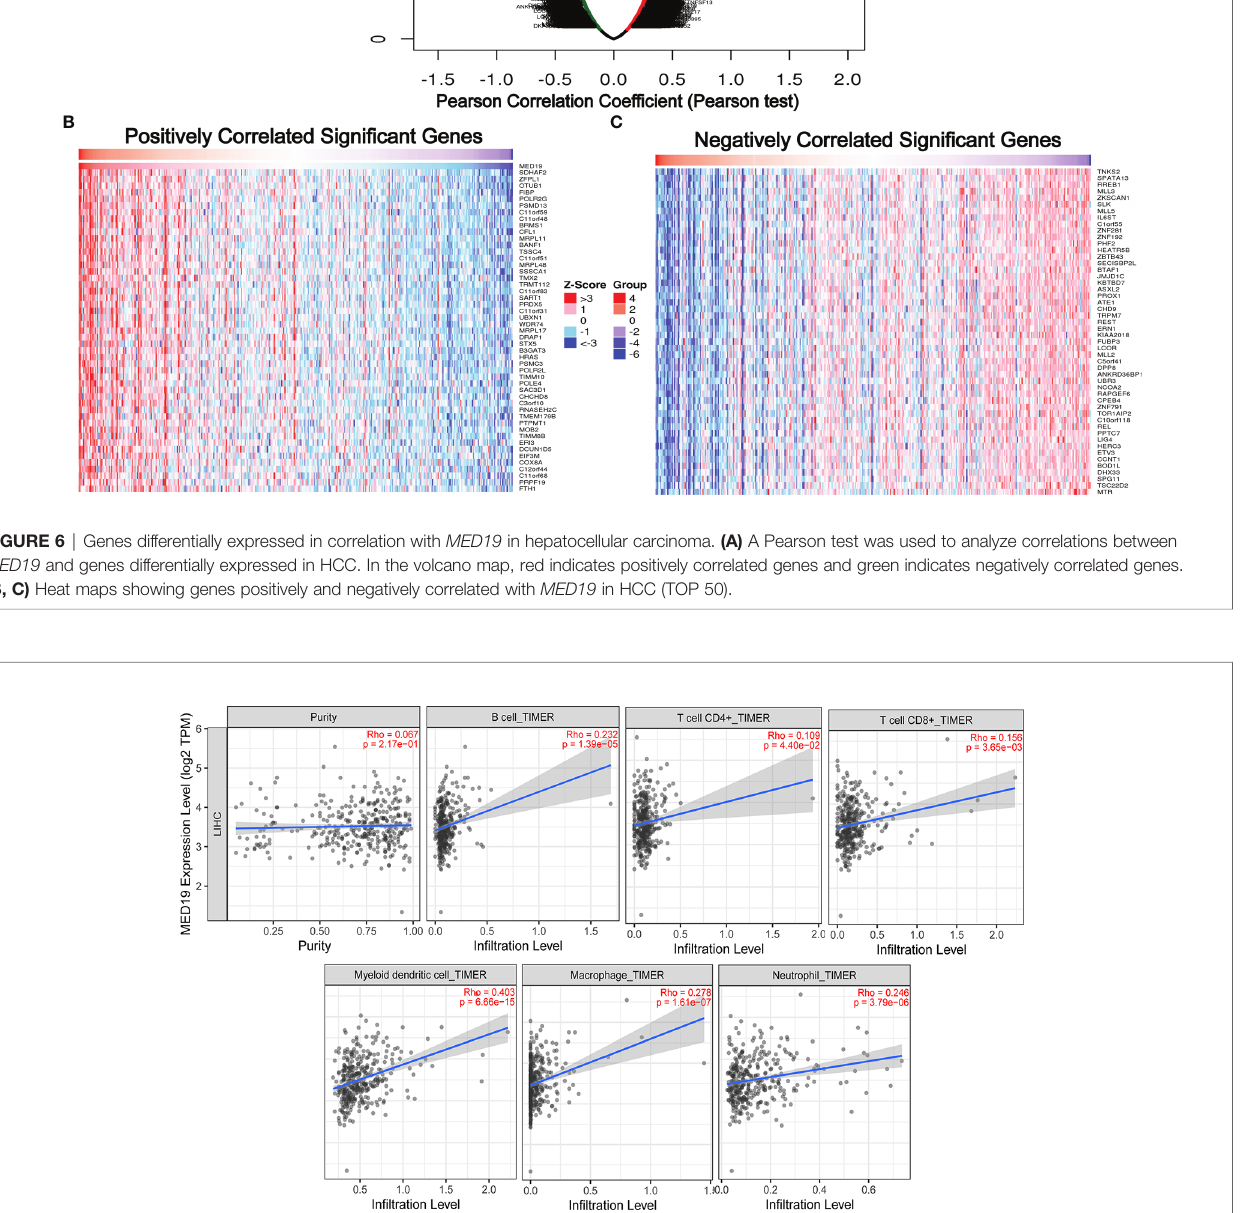
FIGURE 7 | Correlation analysis between the expression of MED19 and the level of immune cells in fi ltration in HCC. After tumor purity adjustment, MED19 expression in HCC was positively correlated with in fi ltration levels of B cells, CD4 + T cells, CD8 + T cells, myeloid dendritic cells, macrophages, and